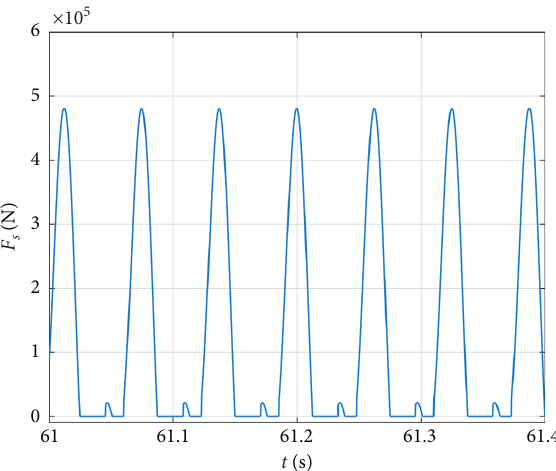
Figure 7: Dynamic responses of the rigid drum ( k Poincare